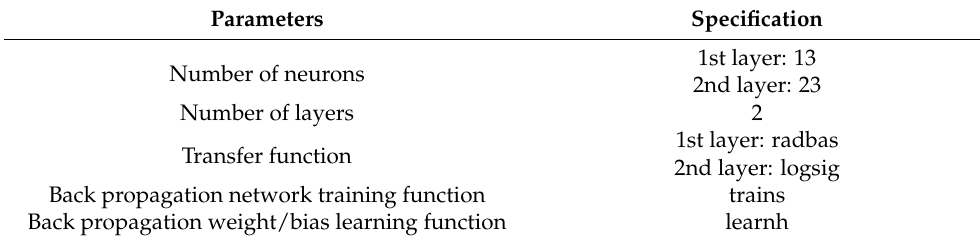
Table 1. The structure of ANN-SA for selecting the most effective